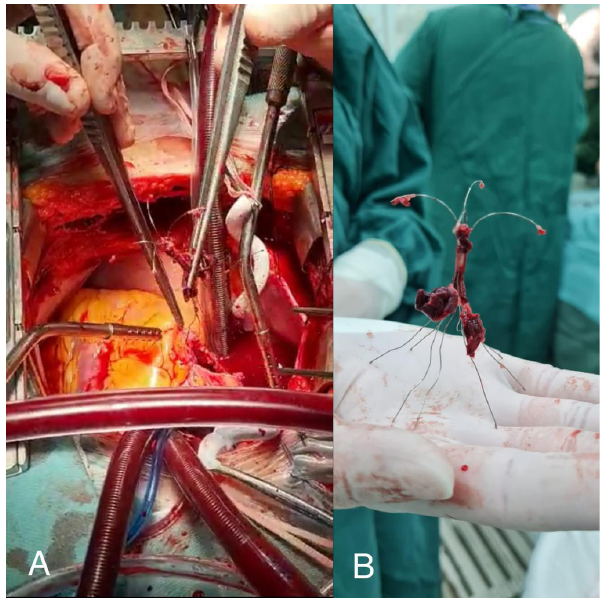
Fig. 3 - A) Inferior vena cava filter (IVCF) removal after right atriotomy; B) IVCF with clots after removal.